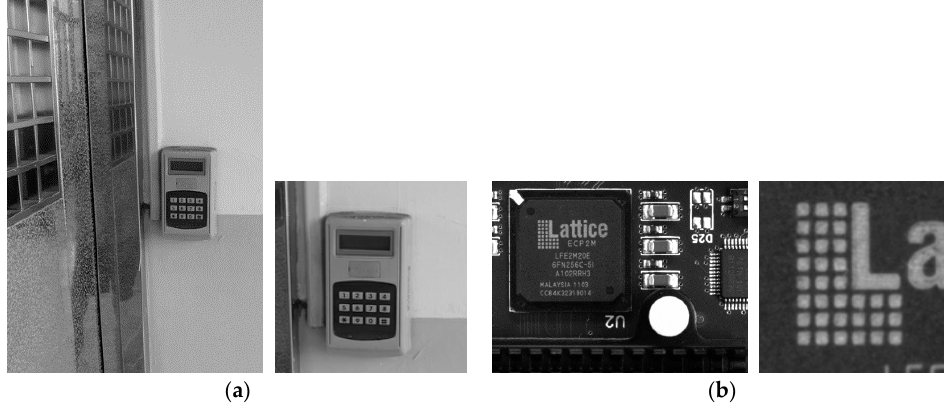
Figure 13. Test images. The sizes of test images are ( a ) 414 × 525; ( b ) 800 × 600; and the corresponding template images are ( a ) 170 × 170; ( b ) 120 × 120.